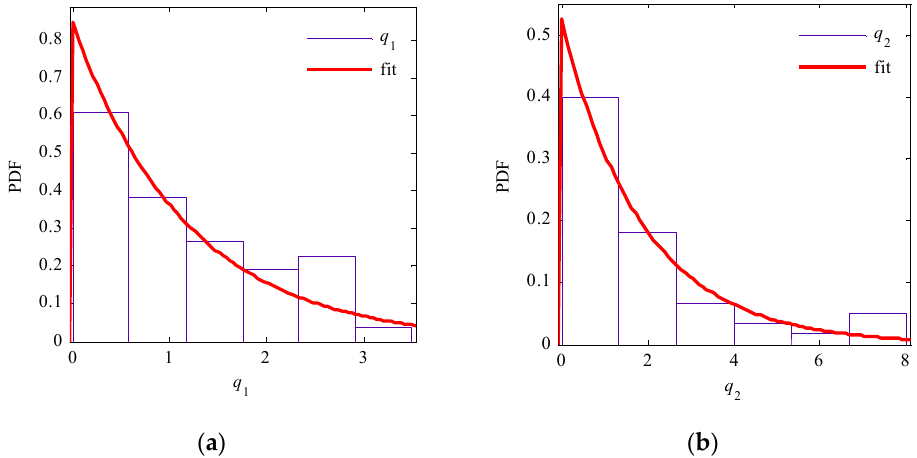
Figure 18. Distribution fitting of ( a ) parameter q 1 and ( b ) parameter q 2 in the phase transfer